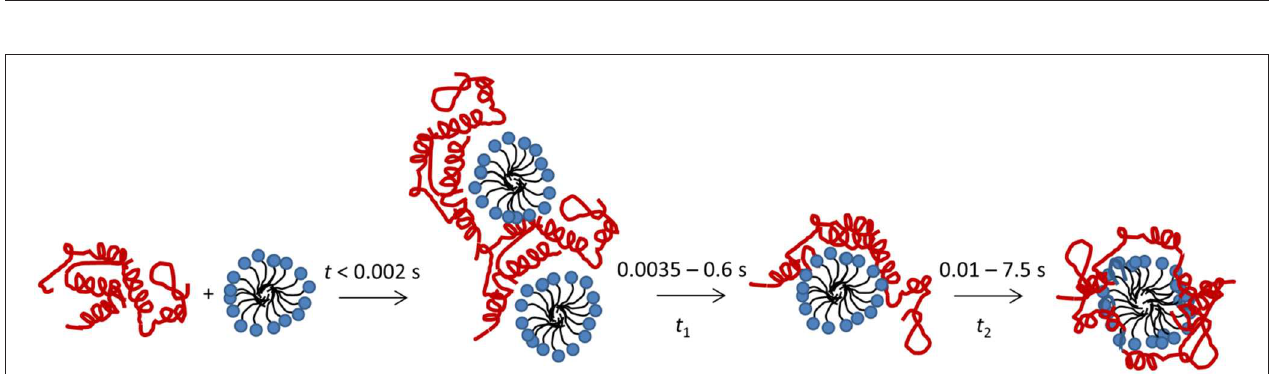
FIGURE 7 | Schematic representation of the unfolding process after mixing of aLA (red) and SDS (blue).